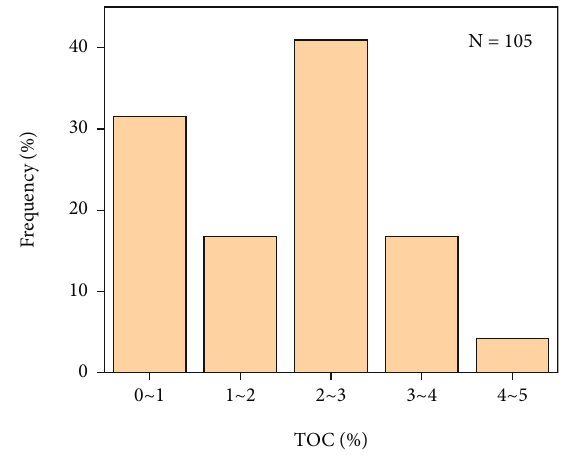
Figure 3: Histogram showing the TOC of the LF in the study